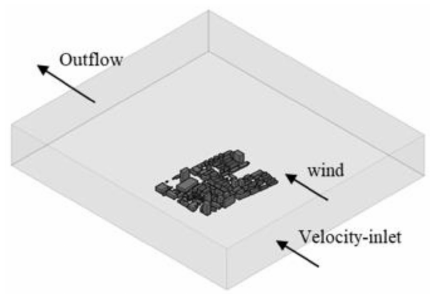
Figure 3. Modeling for the standard CFD method.